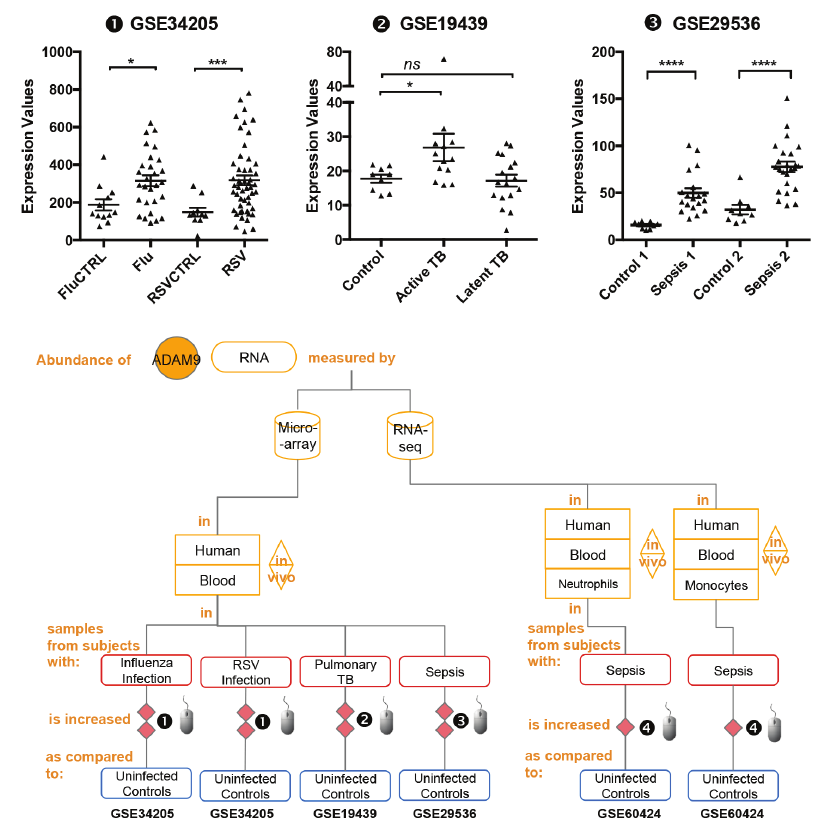
Figure 2. The abundance of ADAM9 increases during infection. mRNA expression levels for ADAM9 was measured by microarrays in whole blood obtained from children hospitalized with acute RSV and influenza virus infection (GSE34205), pulmonary tuberculosis patients (GSE19439) and patients with sepsis